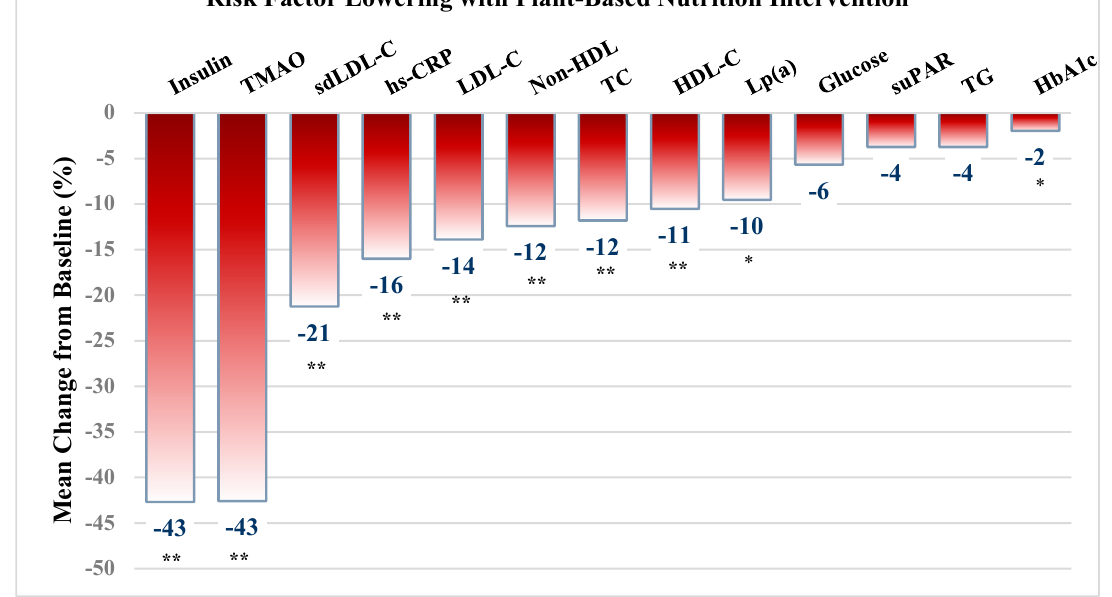
Figure 1. Cardiovascular and cardiometabolic risk factor lowering with plant-based nutrition intervention. Values are presented as mean ± SD. * significant at p < 0.01 level; ** significant at <0.001 level. BMI = body mass index; TC = Total cholesterol; sdLDL = small dense LDLc; LDL = Low density lipoprotein, HDL = high density lipoprotein; non-HDL = non- HDL cholesterol; TG = triglycerides; hsCRP = high-sensitivity C-reactive protein; suPAR = soluble urokinase plasminogen activator receptor; TMAO = trimethylamine-N-oxide.